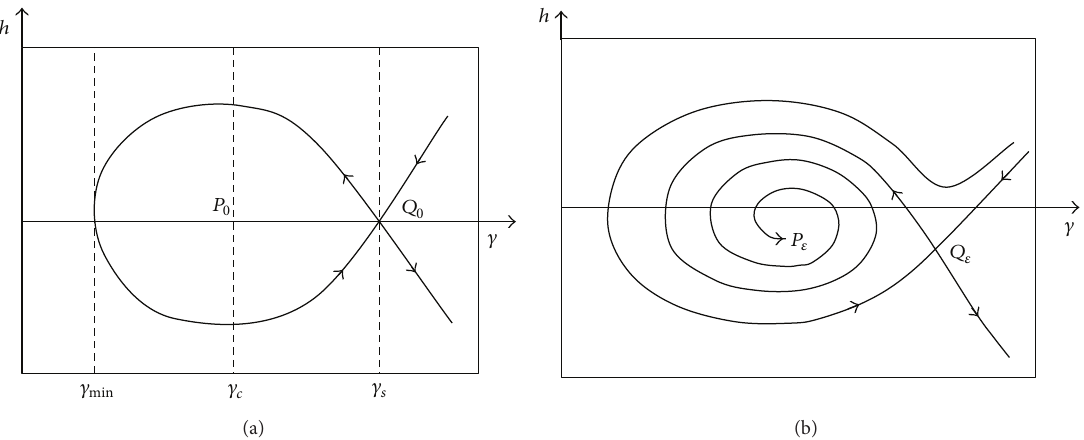
Figure 3: Dynamics on the normally hyperbolic manifold is described; (a) the unperturbed case; (b) the perturbed case.